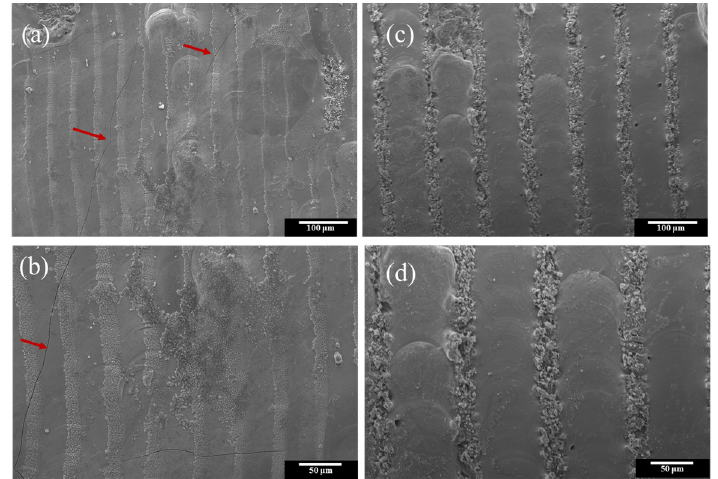
Figure 6. ( a ) Low-magnification and ( b ) high-magnification SEM images of the top surface of single MoSiBTiC-La 2 O 3 layer with 50 µ m HD (Cracks are indicated by red arrows); ( c ) low-magnification and ( d ) high-magnification SEM images of the top surface of single MoSiBTiC-La 2 O 3 layer with 100 µ m